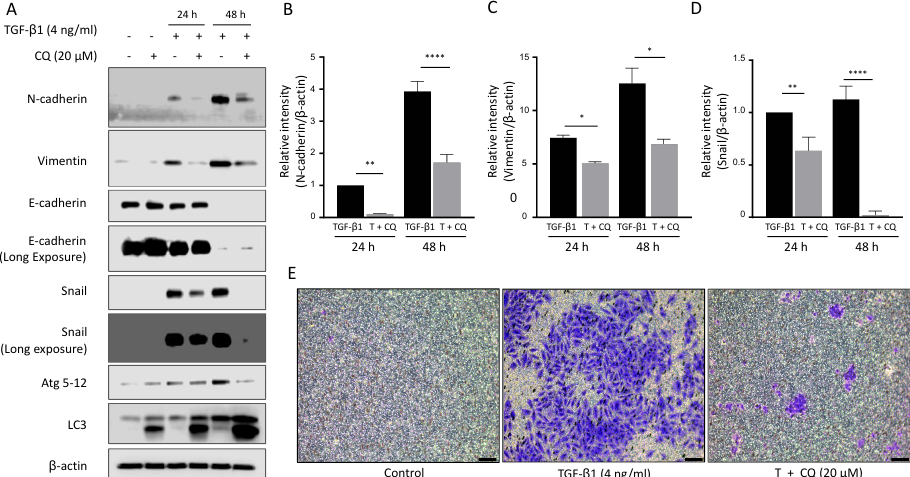
Figure 3. Inhibition of autophagy down-regulates mesenchymal protein expression and invasion ability. ( A ) Western blotting. Protein expression of EMT and autophagy markers in A549 were detected after treatment with TGF- β 1 4 ng/mL or 20 µ M chloroquine for 24 h and 48 h. ( B – D ) Graph representing the relative intensity of N-cadherin and Vimentin, SNAI1 normalized by β -actin. Data represent the mean ± s.d of three independent experiments. **** p < 0.0001; ** p < 0.01; * p < 0.05 p -value were evaluated by two-way ANOVA followed by Tukey’s test. ( E ) Invasion assay. A549 cells were placed in the upper chamber of the basement membrane layer under TGF- β 1 or TGF- β 1 with chloroquine treatment for 24 h. A549 cells that passed the basement membrane at the bottom of the insert chamber were captured by bright-field microscopy. Bar, 100 µ